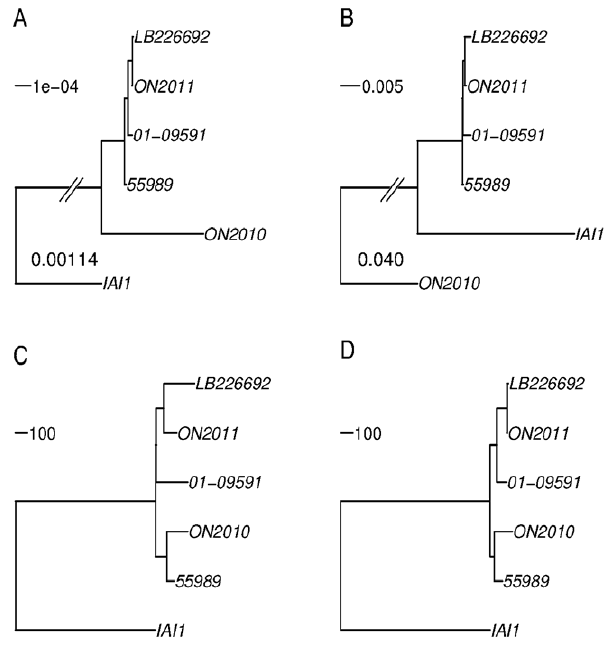
Figure 3. E.coli O104:H4 phylogenies constructed based on the 3794 shared genes using different methodologies. A), maximum likelihood tree of the concatenated sequences (3613248 characters). All branches are 100% bootstrap supported. The branch length separating IAI1 from the E. coli O104:H4 strains is not to scale and the length is shown. B), feature frequency profiles (FFPs) tree. ON2010 is shown to be distinct from the remaining E. coli O104:H4 strains and IAI1. The branch length separating ON2010 from other strains is not to scale and the length is shown. C), neighbor-joining tree based on the number of alleles that differ between any two strains. D), neighbor-joining tree based on the number of alleles that have none-zero DNA distance between any two strains. Unlike in C, small indels, including possible homopolymer sequencing errors, were not considered in D.